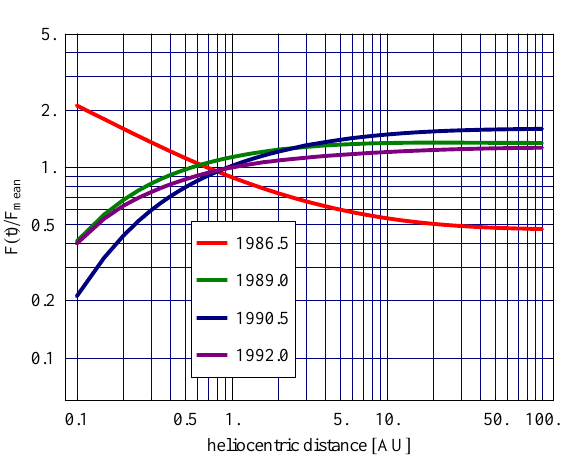
Fig. 15. The actual flux of He + pickup ions with respect to the flux averaged over time, for selected epochs during the solar cycle, presented as function of heliocentric distance along the crosswind axis in the log-log scale. The epochs are color-coded in the inset box.